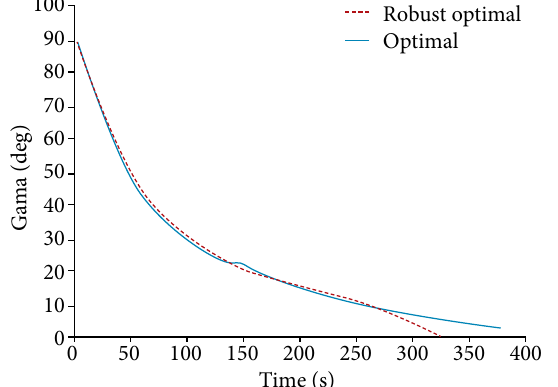
Figure 15. Comparison of trajectory angle in optimal and robust